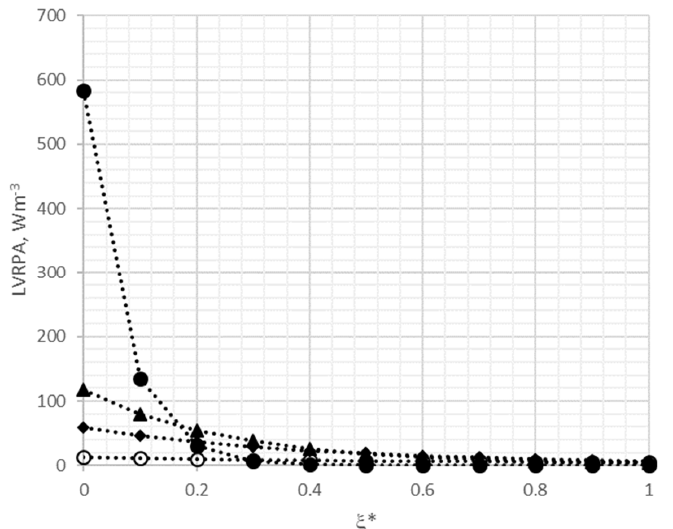
Figure 3. Local Volumetric Rate of Photon Absorption (VRPA) vs. ξ * from Six Flux Model (SFM) adapted to the external four-lamp photoreactor. Variation with dimensionless radial position within the reaction space and catalyst concentration. Catalyst concentration, gL − 1 : 10 − 3 , 5 × 10 − 3 , 10 − 2 , 5 × 10 − 2.